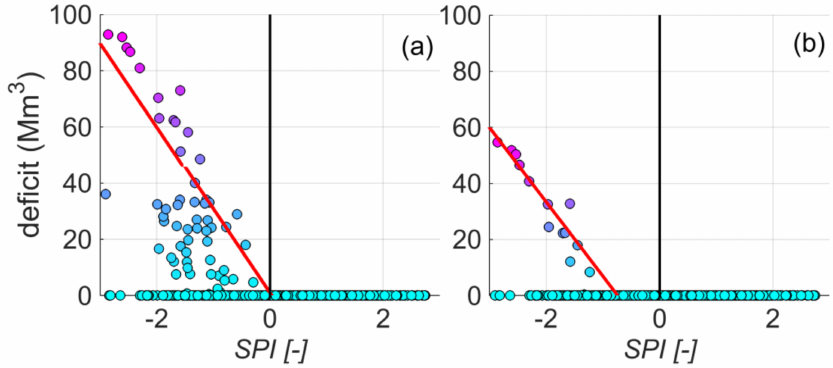
Figure 3. Example of quantitative analysis of the SUPPORT TO EARLY-WARNING